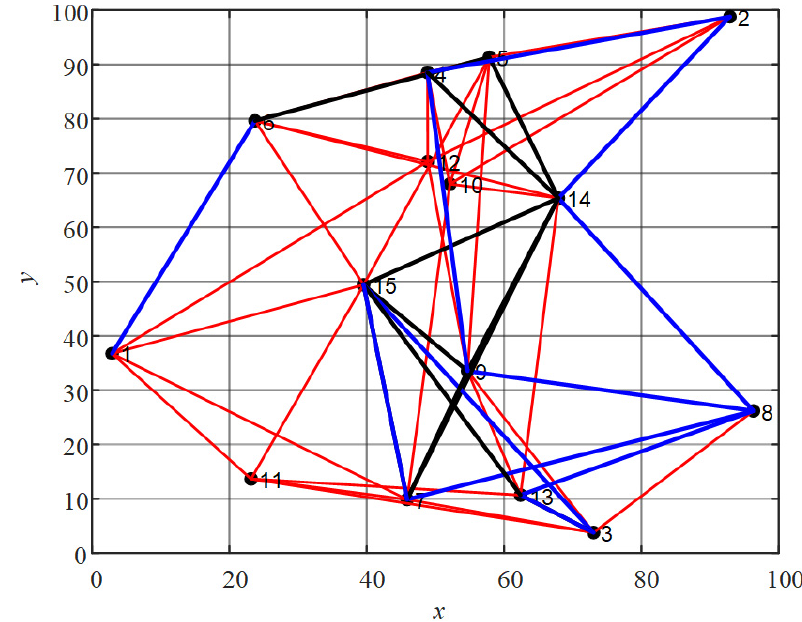
Figure 2. The corresponding adjustments of the original